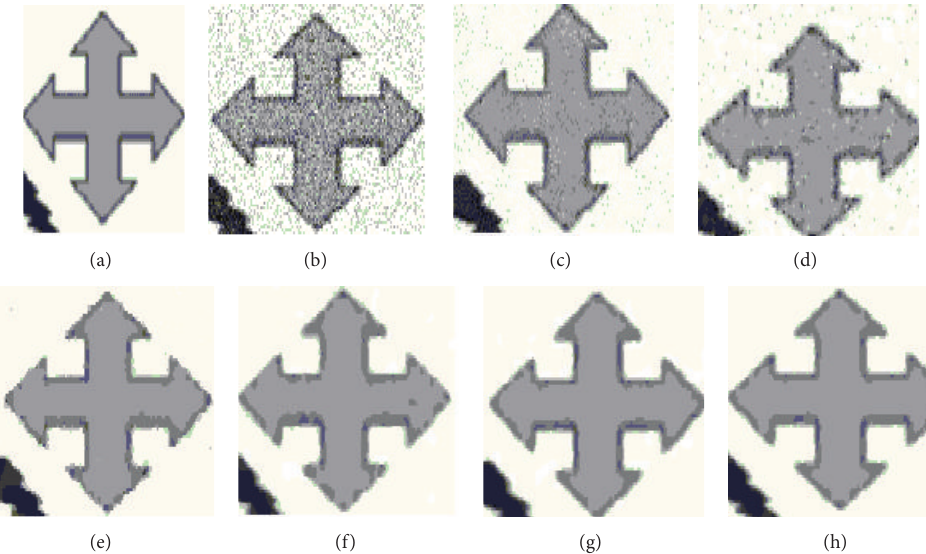
Figure 2: A part of the results of the synthetic image by the five models: (a) original image, (b) noisy image, (c) result by NLM, (d) result by Y-K model, (e) result by PM, (f) result by TV, (g) result by MTV, and (h) result by our